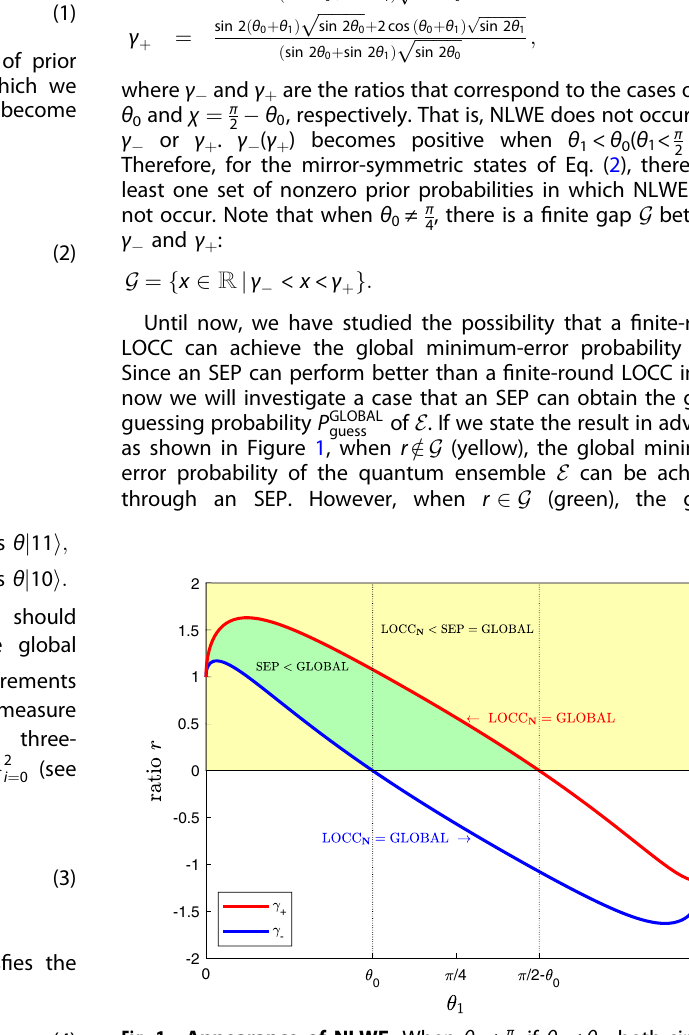
Fig. 1 Appearance of NLWE. When θ 0 ≠ π , if θ 1 < θ 0 , both singular 4 rates γ − and γ + are valid. However, when θ 1 (cid:4) π (cid:2) θ 0 , both γ − and γ + 2 are not valid. If θ 0 (cid:5) θ 1 < π (cid:2) θ 0 , γ + is valid but γ − is not. When the 2 ratio r becomes γ − (blue) or γ + (red), the global minimum-error probability of a quantum ensemble E can be achieved by a fi nite- round LOCC, otherwise it cannot be obtained by fi nite-round LOCC. Furthermore, if r = 2G (yellow), the global minimum-error probability of the quantum ensemble E can be achieved by means of a separable measurement. Meanwhile, when r 2 G (green), the global minimum-error probability of a quantum state ensemble E cannot be obtained by a separable